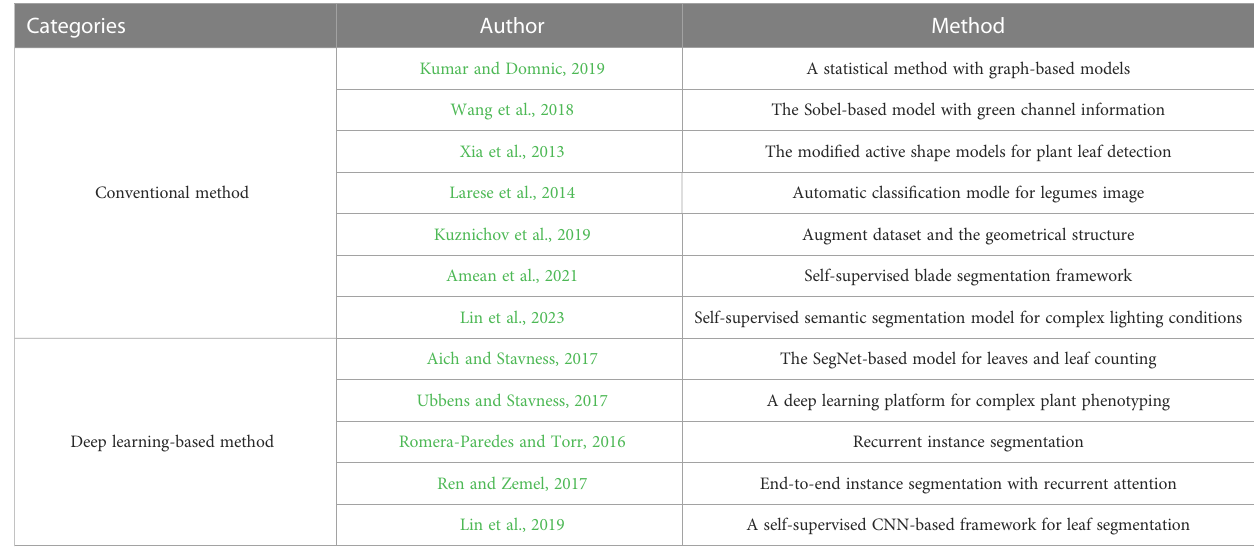
TABLE 1 The related works in plant leaf